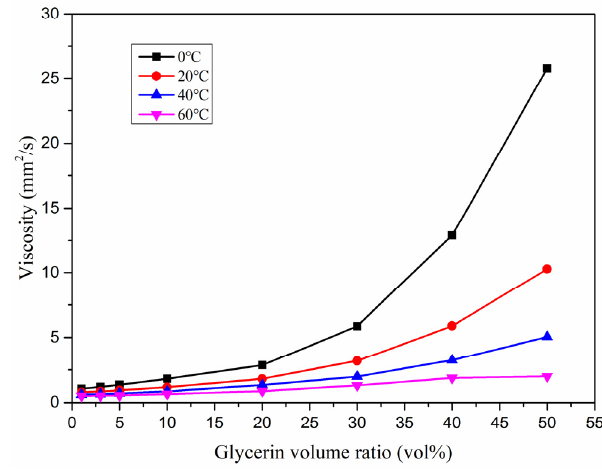
Figure 3. Variation of kinematic viscosity of mixed fuels.